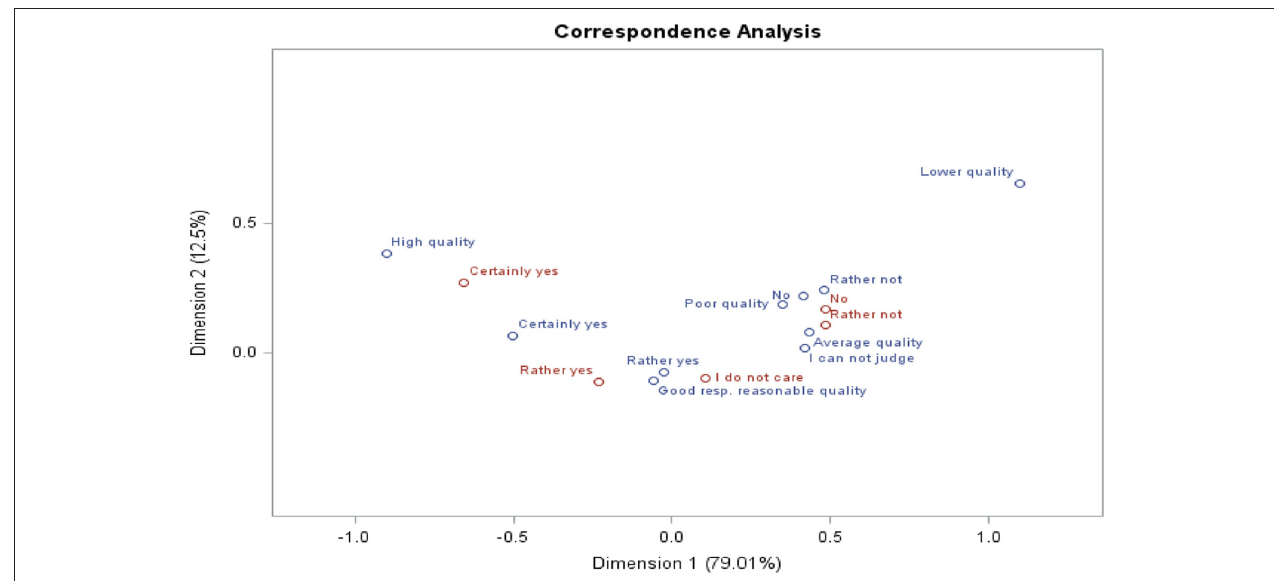
FIGURE 4 | Output of the correspondence analysis. Source: Results of the questionnaire survey, output of the SAS program 9.4.